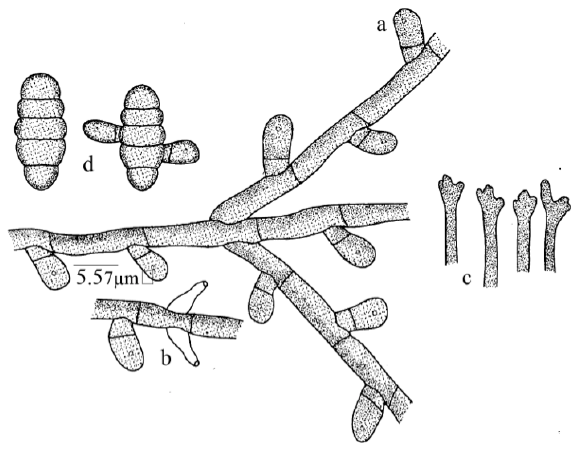
Figure 37. Meliola ailanthi a - Appressorium; b - Phialide; c - Apical portion of mycelial setae; d - Ascospores